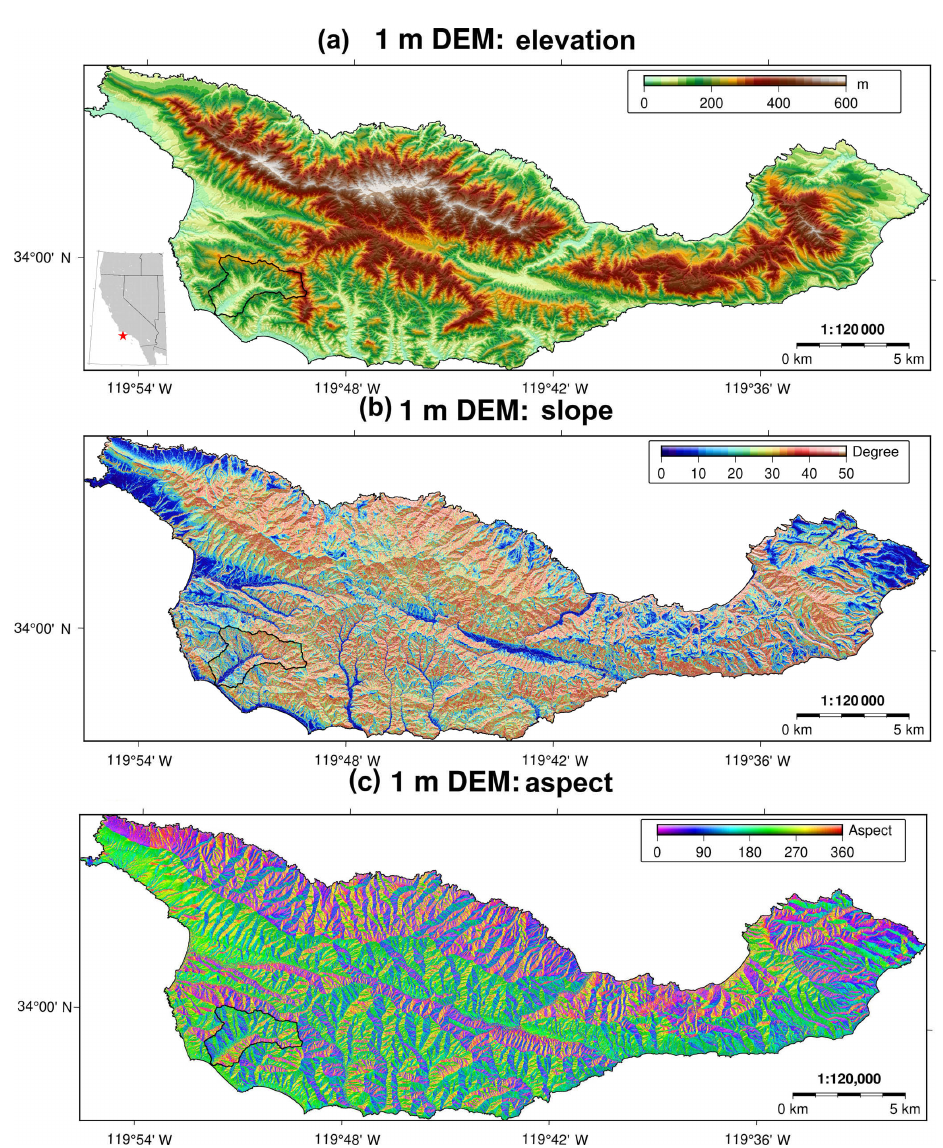
Figure 9. Topographic setting of Santa Cruz Island (SCI), showing elevation (a) , slope (b) , and aspect (c) derived from a 1m DEM and calculated from a total of 2 . 3 × 10 9 ground-classified lidar points. The SCI covers a wide range of terrain types, slope regimes, and all aspect directions. The black polygon (southwest SCI) indicates the Pozo catchment shown in Fig. 10. For a canopy height model, we refer to Fig.